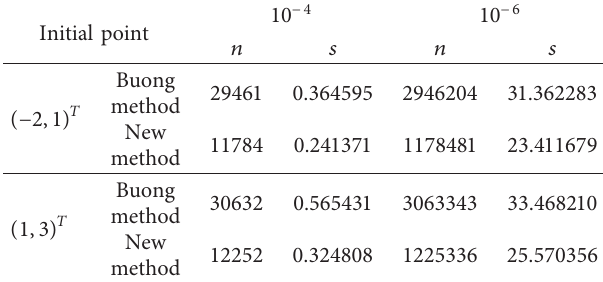
Table 1: Computational results for Example 1 with different